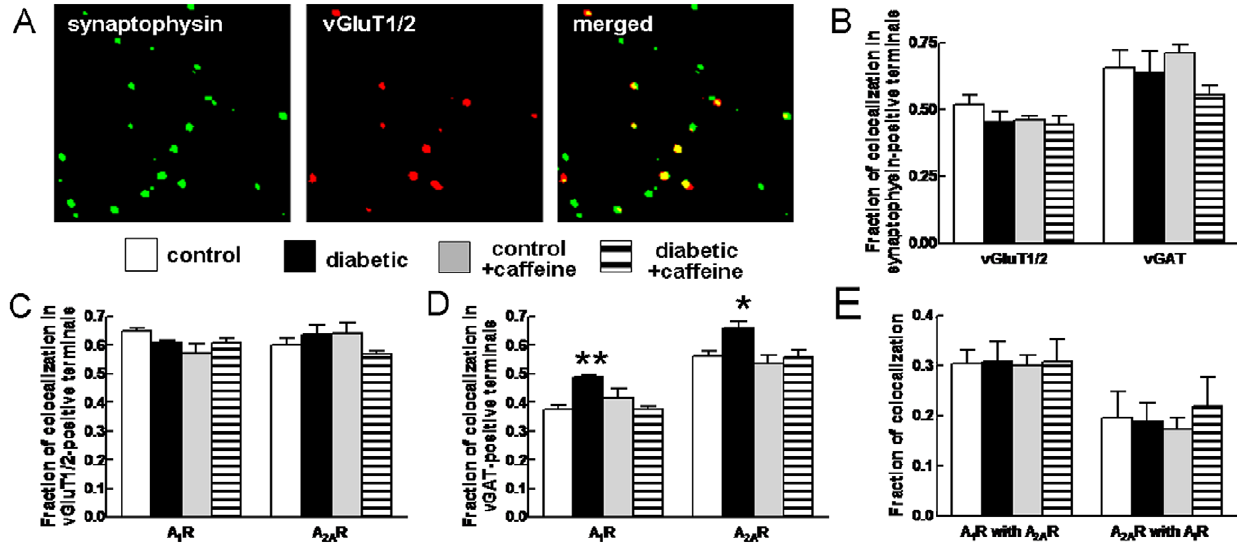
Figure 7 . Co-localization of A 1 R and A 2A R in glutamatergic and GABAergic nerve terminals purified from the hippocampus . Panel (A) exemplifies the double immunostaining performed, here determining the fraction of glutamatergic (vGluT1/2-positive) terminals (synaptophysin immunoreactivity). The fraction of glutamatergic and GABAergic nerve terminals in the hippocampus was similar in the four experimental groups (B). The fraction of glutamatergic terminals containing A 1 Rs or A 2A Rs was not altered (C) but diabetic mice displayed increased number of GABAergic terminals endowed with A 1 R or A 2A R (D). The fraction of nerve terminals immunoreactive for both A 1 Rs and A 2A Rs was similar in the four animal groups (E). White, black, grey and striped bars represent control, diabetes, diabetes plus caffeine and caffeine groups, respectively. Data are mean 6 SEM of n=5–6 mice in each experimental group. *P , 0.05, **P , 0.01 versus control.